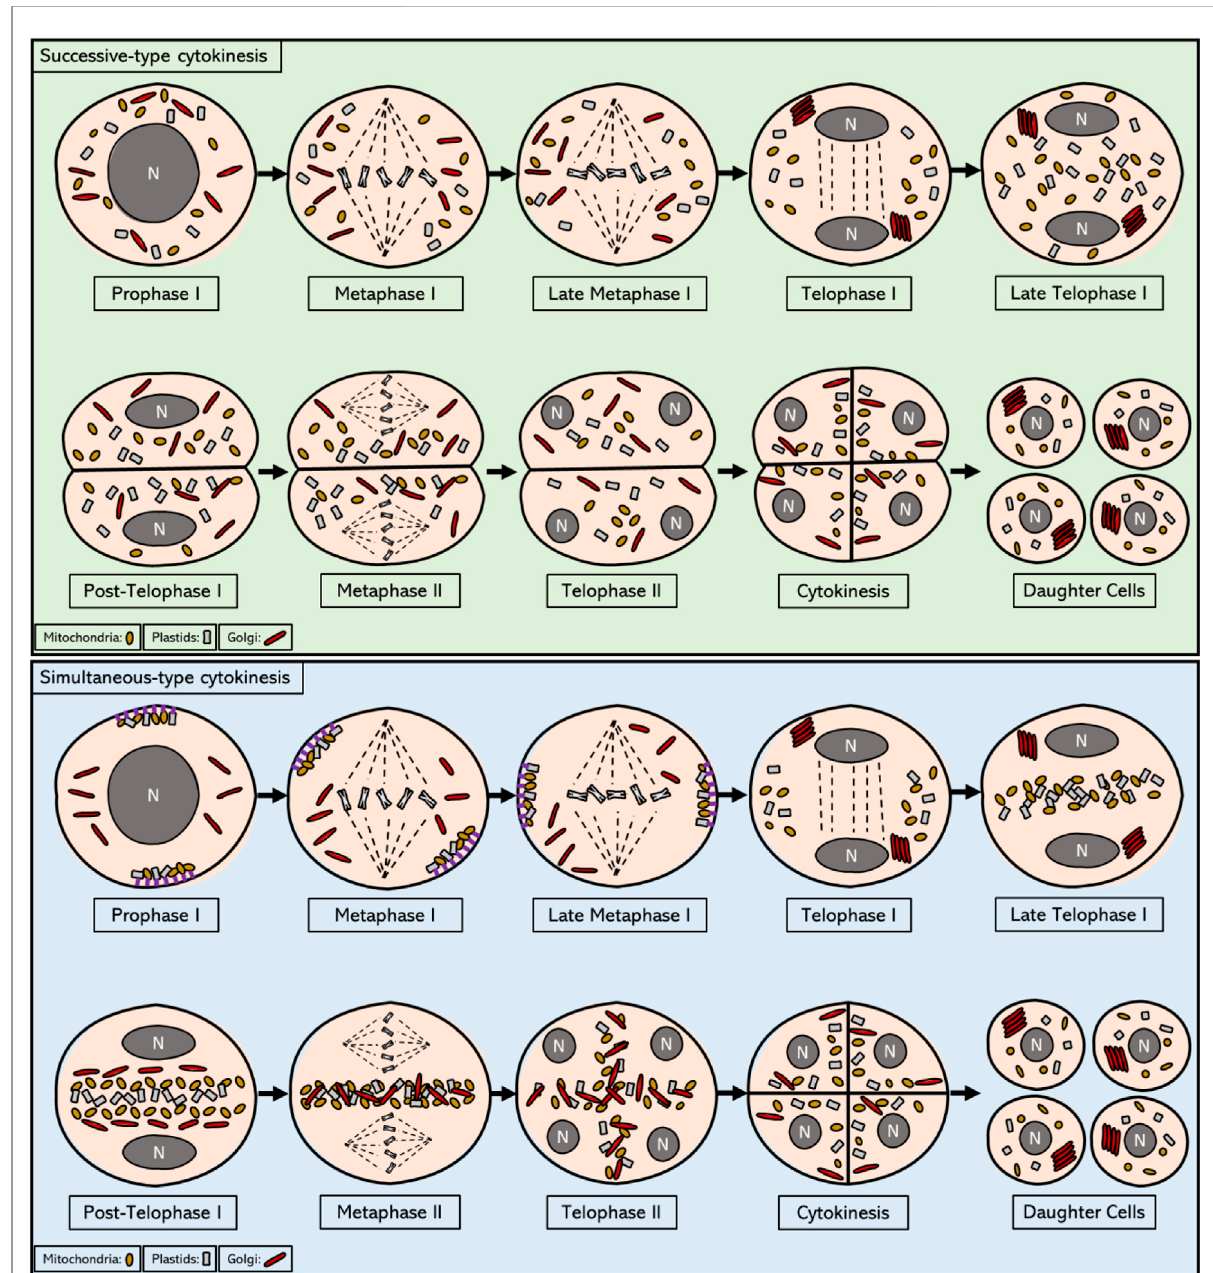
FIGURE 1 Intracellular localization of mitochondria, plastids, and Golgi from prophase I to telophase II in meiotic cells that exhibit successive and simultaneous type of cytokinesis. In the most prevalent form of successive cytokinesis, mitochondria, plastids and Golgi bodies are dispersed in the cytoplasm from prophase I until the end of metaphase I. In telophase I, Golgi stacks reassemble and move towards the newly formed nuclei. By the end of telophase I, fi rst callose wall is formed and the pollen mother cell enters the dyad stage, consisting of 2 cells within the same cell wall. In some plant organisms with successive-type cytokinesis, as for example in Larix europea, a short formation of an equatorial organelle band is observedduringthisstagethatdispersesassoonascallosewallisformedattheendoftelophaseI.Theorganellesremainscatteredinthecytoplasm until the end of telophase II, when the second callose wall is formed, yielding the four haploid daughter cells. Overall, the organelle movements during this process are reminiscent of mitotic cell division, in which an active regulation of organelle motility seems to be non-existent. In plant meiocytes with a simultaneous-type of cytokinesis, mitochondria and plastids are grouped on the opposite sides of the cell towards the end of prophase I and are attached to cell cortex via anchor proteins, while stacks of Golgi bodies are found scattered in the cytoplasm in a disassembled form. During metaphase I all organelle types start migrating towards the central midzone, and by the end of metaphase I they are grouped in the cytosol near the chromosomes. During telophase I, Golgi stacks reassemble and localize in close proximity to the newly formed nuclei, whereas mitochondria and plastids start occupying the cytoplasmic space at the equator of the cell. At the end of telophase I, Golgi stacks also join the